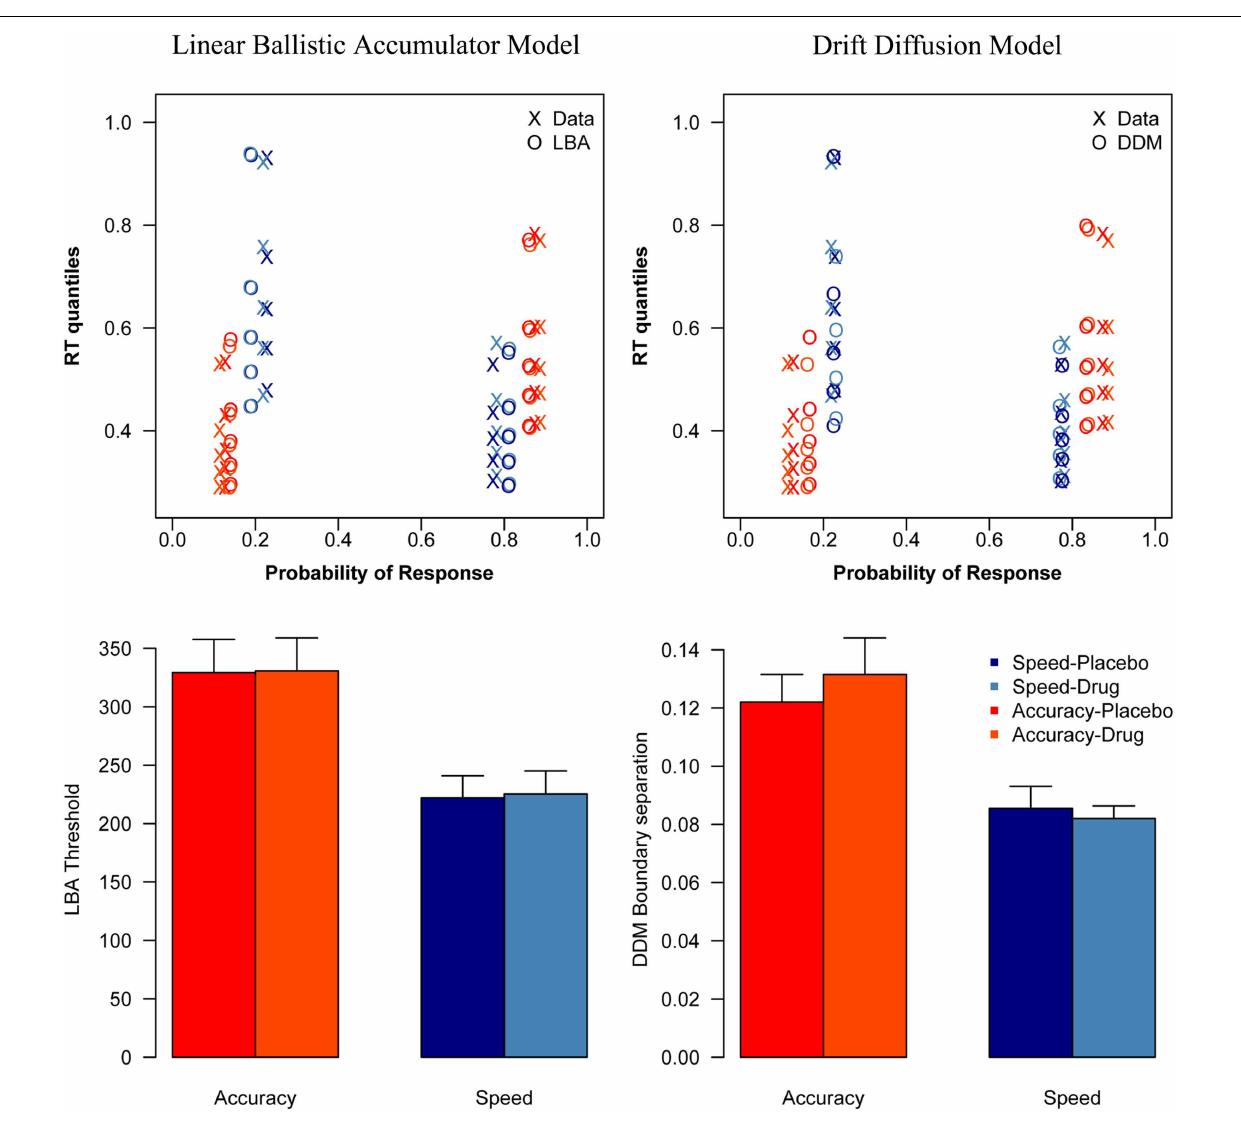
FIGURE 3 | Model fits and parameter estimates. This figure shows the vincentized behavioral data and model fits (top) and the threshold estimates per experimental condition (bottom) of the LBA model (left) and the DDM